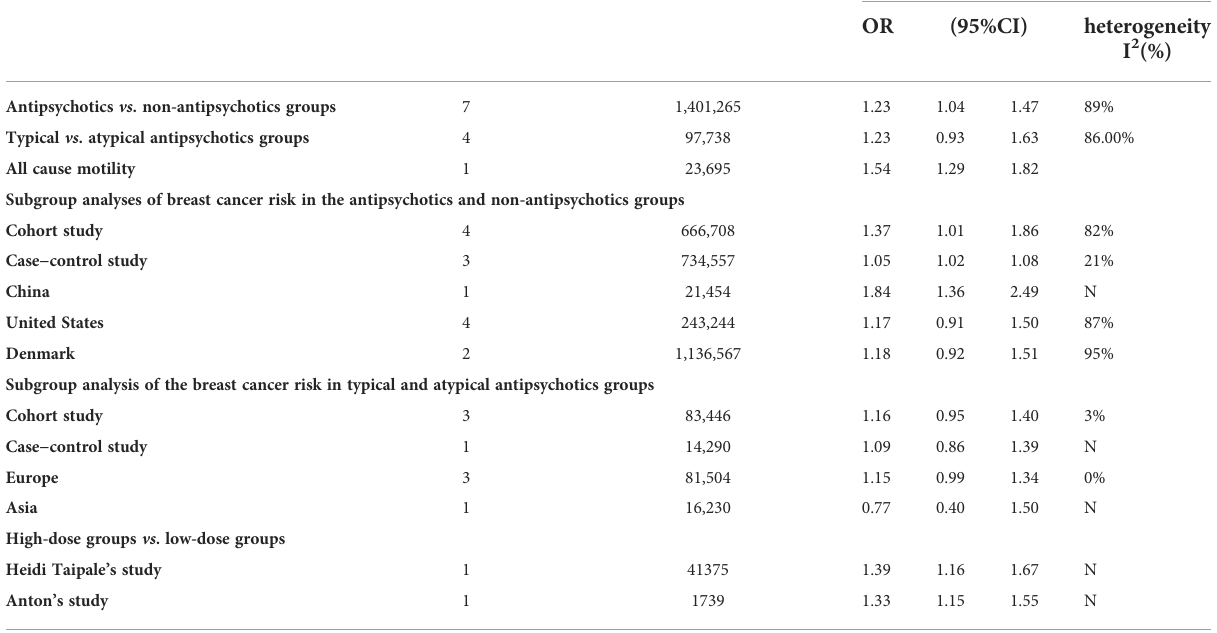
TABLE 2 Summary of fi ndings.